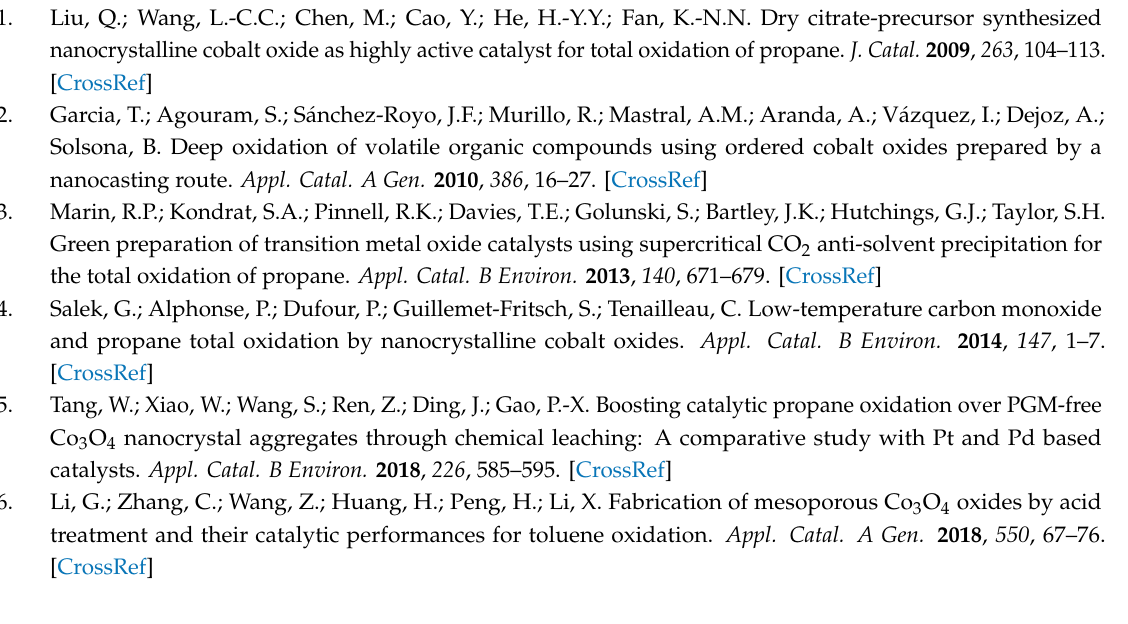
Figure S1: Variation of the (a) toluene conversion (b) propane conversion with the reaction temperature during the heating run, Figure S2: Evolution of (a) CO concentration in toluene oxidation and (b) C 3 H 6 concentration in propane oxidation during one heating − cooling catalytic cycle over the Co 3 O 4 and M 0.05 Co catalysts, Figure S3: Arrhenius plots for (a) toluene oxidation (b) propane oxidation over Co 3 O 4 and M 0.05 Co catalysts. (reaction conditions: toluene / propane concentration = 1000 ppm, O 2 concentration = 21 vol.% and WHSV = 40,000 mL h − 1 g − 1 ), Figure S4: Constable plot of apparent pre-exponential factors as a function of apparent activation energies for toluene and propane oxidation over Co 3 O 4 and M 0.05 Co catalysts, Figure S5: CO 2 evolution as a function of time on stream in air flow after 24-h stability test, Figure S6: Toluene conversion to CO 2 as a function of time on stream over Co 3 O 4 catalyst at 230 ◦